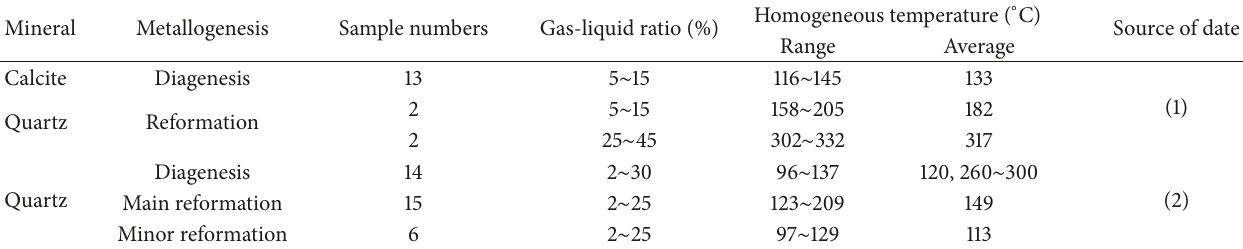
Table 1: Homogeneous temperature of fluid inclusions of minerals in the Dayao